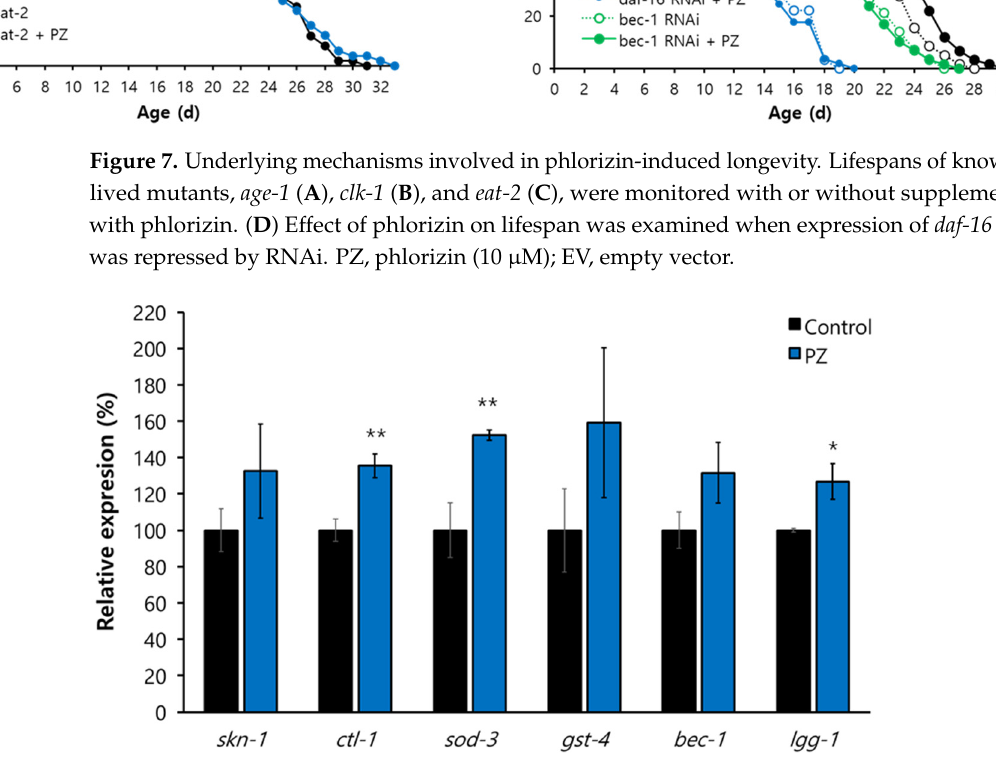
Figure 8. Effects of phlorizin on expression of anti-oxidant and autophagic genes. Quantitative RT-PCR was performed with total RNA extracted from 9-day-old worms treated with or without phlorizin. Relative percent expression of each gene in phlorizin-treated group was calculated com- pared to 100% for untreated control. *, 0.05 < p < 0.1 compared to untreated control; **, a significant difference ( p < 0.05) compared to untreated control; PZ, phlorizin (10 μ M).